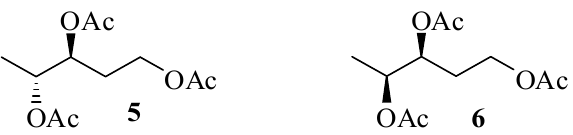
Figure 2. The pentane-1,3,4-triol derivatives used to assign the C18-C19 relative configuration to lipiarmycin A3 and tiacumicin B.